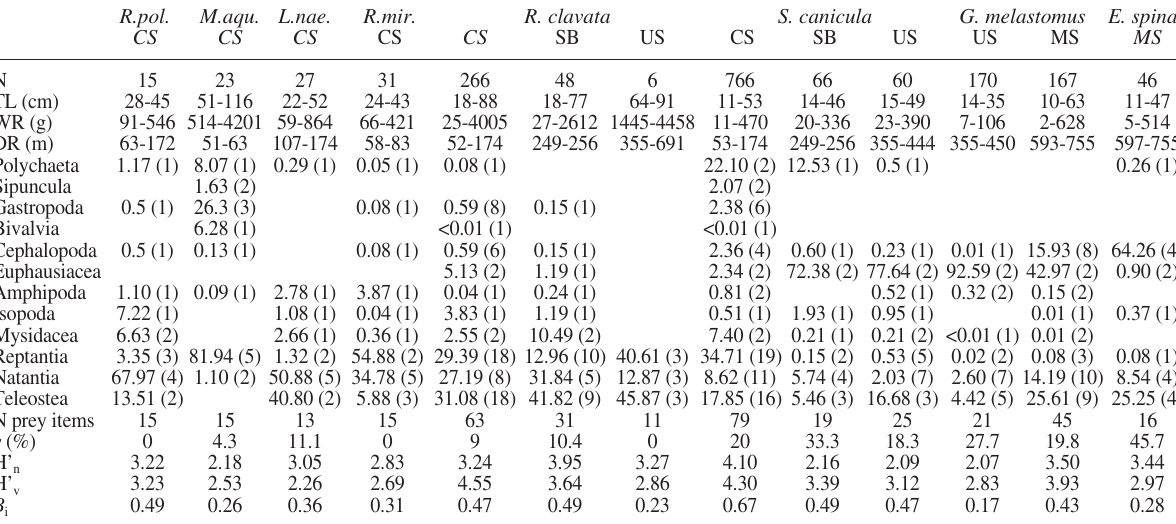
Table 1. – General information and diet composition (standardized index of relative importance, %IRI) of eight elasmobranch species caught at different bathymetric strata (CS, continental shelf; SB, shelf-break; US, upper slope; MS, middle slope) in the Balearic Sea (western Mediterranean). N, sample size; TL, total length; WR, weight range; DR, depth range; v , vacuity index; H’ in number and volume respectively; and B , Levin’s niche breadth. Values in brackets are the number of taxa in the twelve major taxonomic i groups of prey (see Supplementary material Appendix 1). R.pol. , R. polystigma ; M.aqu., M. aquila ; L.nae., L. naevus ; R.mir., R. miraletus.